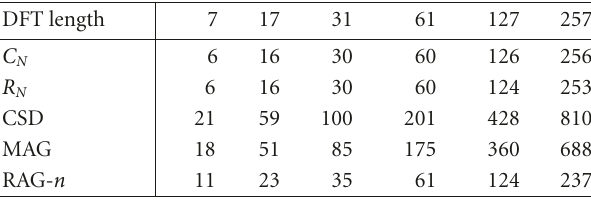
Figure 2: The Bluestein chirp- z algorithm. Table 1: Number of coe ffi cients and costs of Rader multiplier block implementation for 12-bit plus sign coe ffi cients.